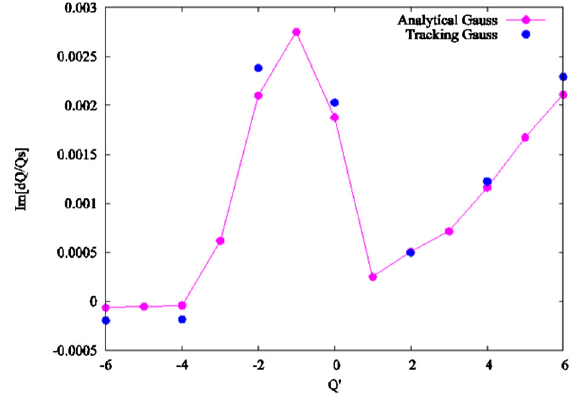
FIG. 3. BeamBeam3D (blue) and NHT (pink) growth rates versus chromaticity for a single bunch, no octupoles and no damper.